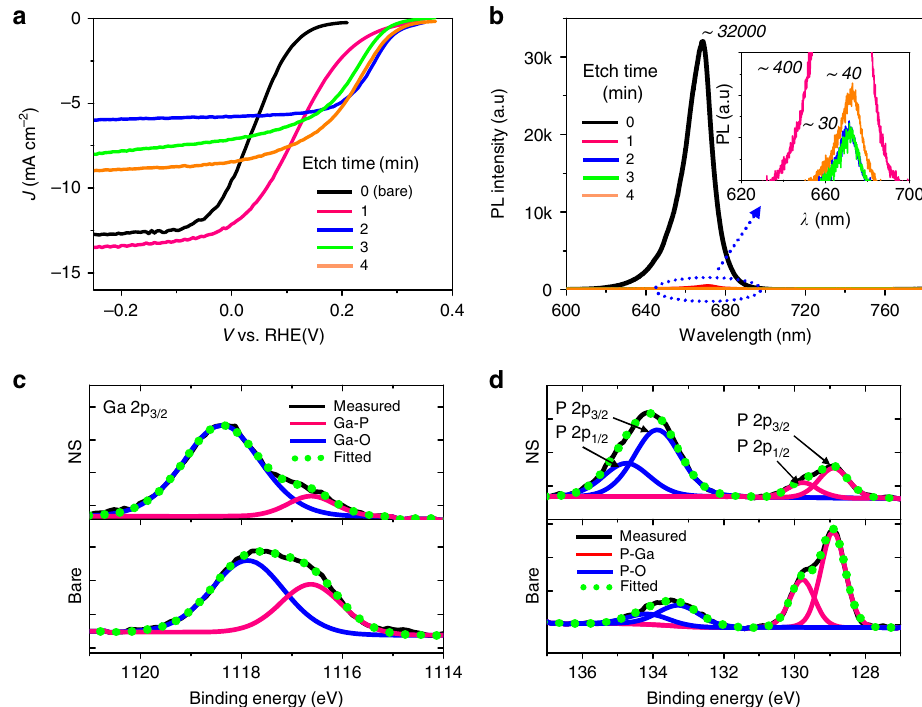
Fig. 2 Photoelectrochemical performance of nanostructured GaInP 2 photocathodes for the HER. a Representative J – E curves of bare and nanostructured GaInP 2 photocathodes driving the hydrogen evolution reaction (HER), measured under simulated AM1.5 G solar illumination (1000 W/m 2 ). All samples were measured without (NH 4 ) 2 S-treatment. b Corresponding steady-state photoluminescence (PL) spectra of bare and nanostructured GaInP 2 photocathodes. c XPS spectra of Ga 2p 3/2 for bare and nanostructured GaInP 2 . The measured spectra (black line) matched quantitatively with fi tted spectra (green dotted line) composed of deconvoluted Ga – O (blue line) and Ga – P (red line) peaks. d XPS spectra of P 2p 1/2 and 2p 3/2 for bare and nanostructured GaInP 2 . The fi tted spectra were deconvoluted to resolve P – Ga (red line) and P – O (blue line)